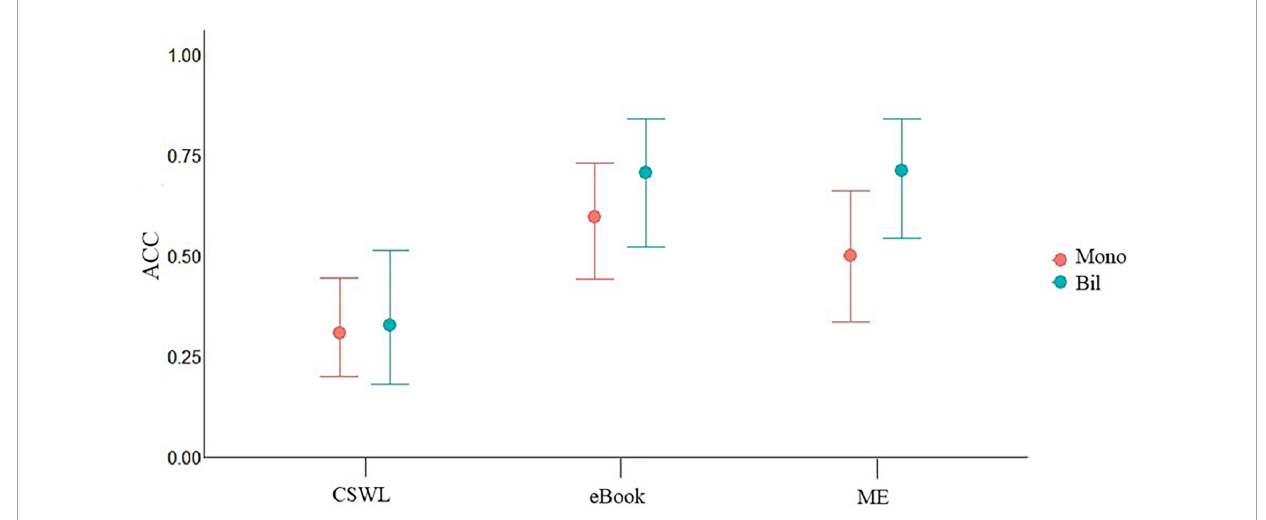
FIGURE7 Visualization of “Condition*lgroup summed Model”. Lgroup_sum includes Mono, monolingual; Bil, bilingual; ACC, response accuracy.